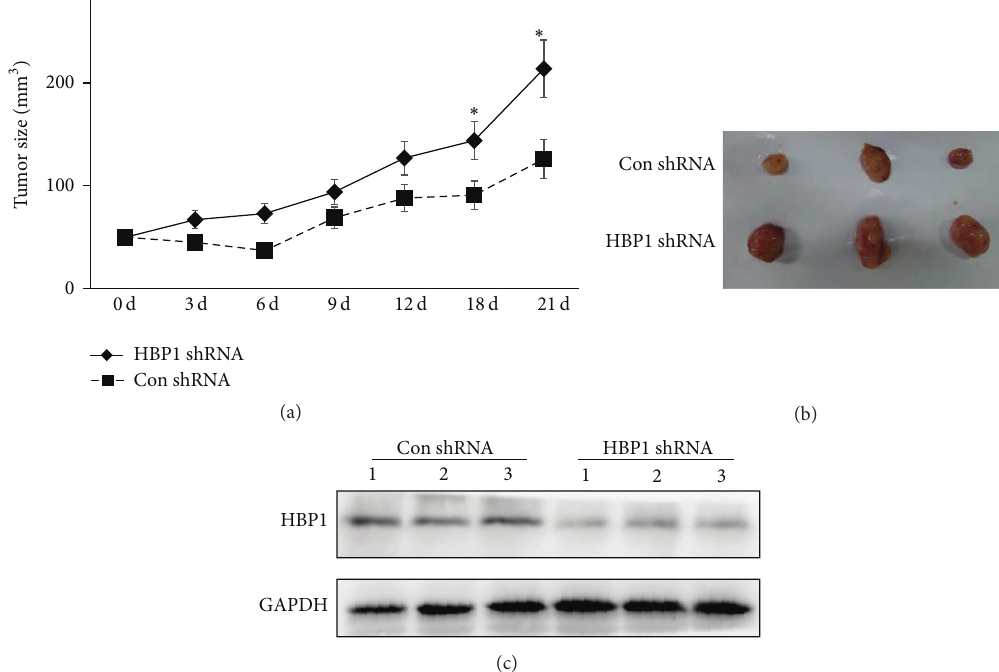
Figure 4: Sensitivity to radiation of xenograft with different expression levels of HBP1 gene. (a) The tumor size was measured in 6-week- old Balb/c male mice in Con shRNA and HBP1 shRNA groups after irradiation. ∗ 𝑝 < 0.05 versus control. (b) The tumor was removed and observed in Con shRNA and HBP1 shRNA groups after irradiation. (c) The expression of HBP1 was detected via western blot in these tumors from Con shRNA and HBP1 shRNA groups after